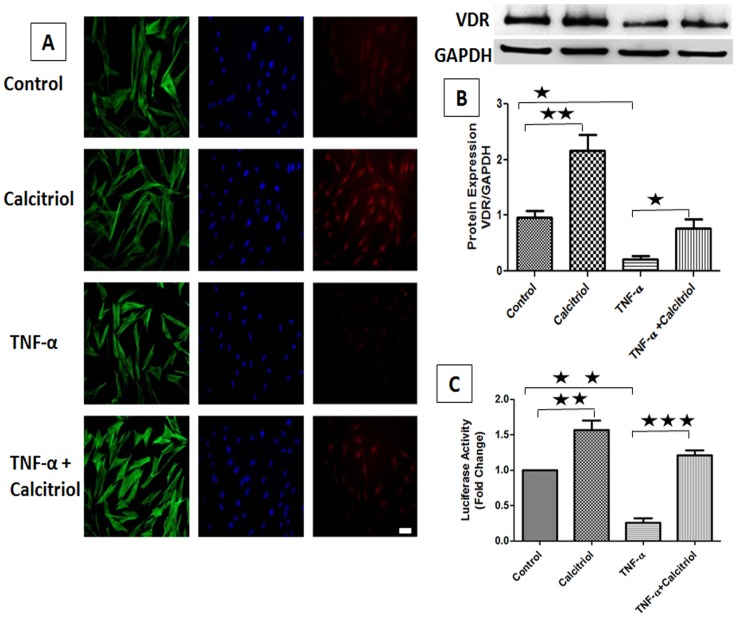
Effect of TNF-α on VDR expression in PCASMCs.(A) PCASMCs cultured in chamber slides were quiesced before addition of 10 nM calcitriol and/or 10 ng/ml TNF-α for 24 h. PCASMCs were fixed, permeabilized and stained with mouse anti-VDR and goat anti-mouse cy3 as secondary antibody. Red color indicates VDR expression and nuclei are stained blue with DAPI. PCASMCs were stained with Alexa Fluor 488 phalloidin as green for filamentous actin. Scale Bar 50 µm, Magnification 200×. (B) PCASMCs were treated with TNF-α (10 ng/ml) and/or calcitriol (10 nM) for 24 hr. Total protein was isolated followed by Western-blot analysis. Relative expression of VDR protein was analyzed against GAPDH. (C) PCASMCs transiently transfected with pVDRE-Luc were treated with 10 ng/ml TNF-α for 24 h in the absence or presence of 1onM calcitriol and subjected to luciferase assay. Fold change in relative luciferase activity was assessed relative to control. Data is shown as mean ± SEM (N = 3). *P <0.05, **P<0.01, ***P<0.001.